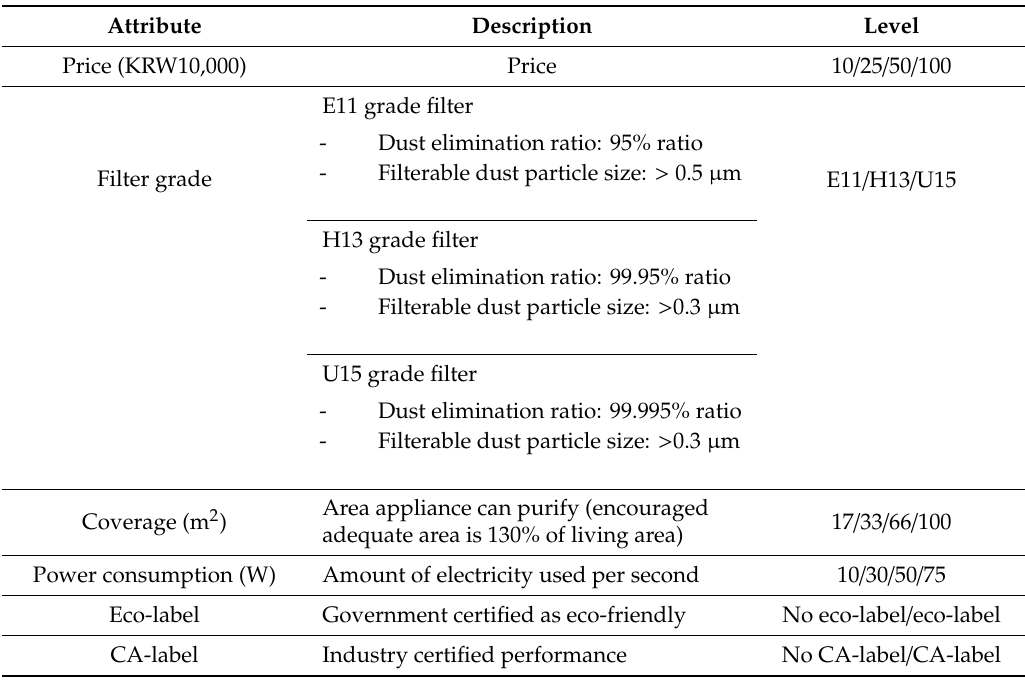
Table 2. Air purifier attributes and attribute levels.